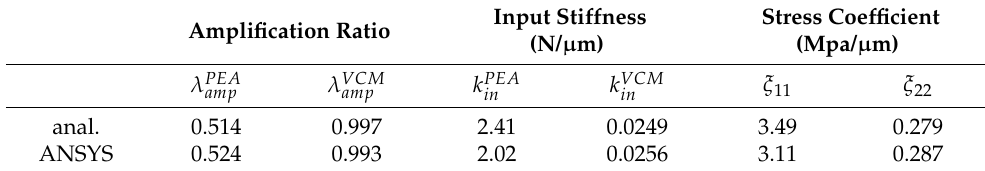
Figure 4. Stress distribution of ACPM while ( a ) actuating the input end of VCM with 38.36 N and fixing the input end of PEA, ( b ) driving the input end of PEA with 121 N and fixing the input end of VCM.